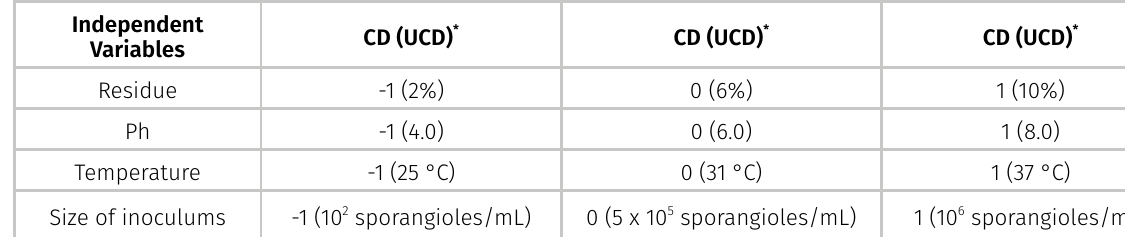
Table I. 2 4 full factorial design, with three central points. Coded (cd) and uncoded (ucd) values to assess the main effects of independent variables on chitosan